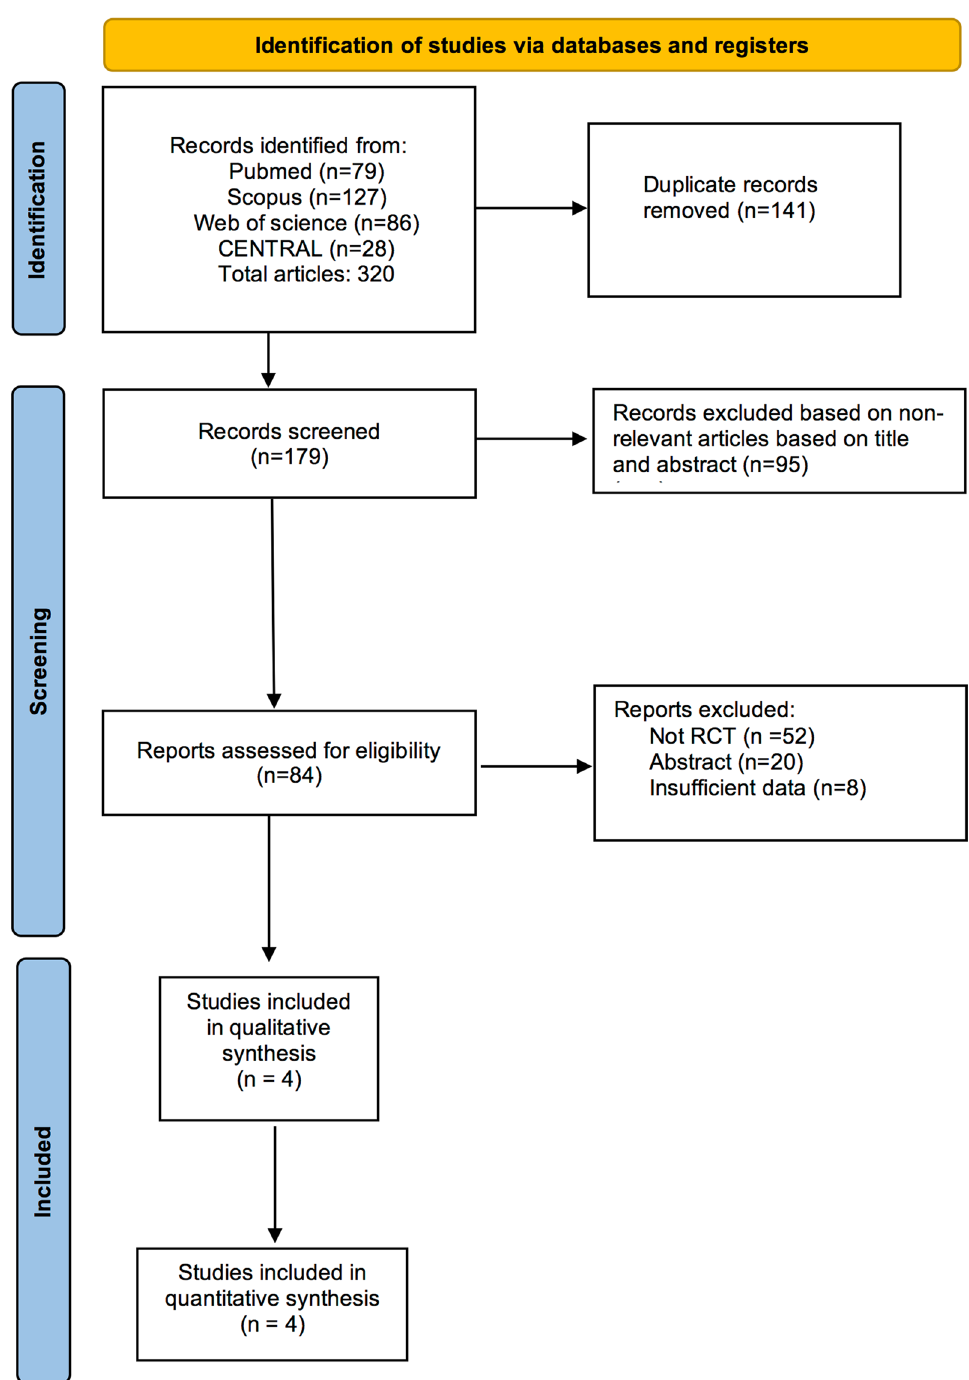
Fig. 1 Study flow diagram based on Preferred Reporting Items for Systematic Reviews and Meta-analyses protocols (PRISMA-P)